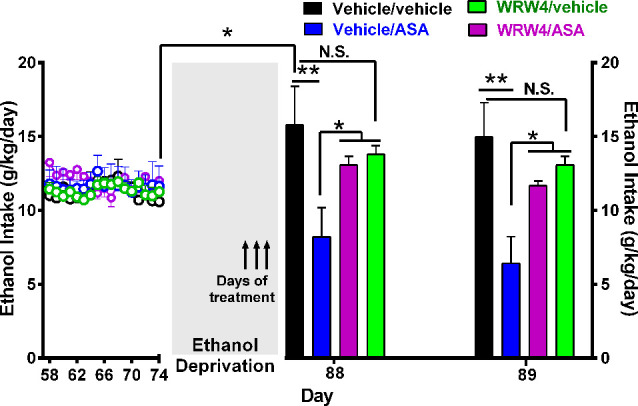
Oral administration of acetylsalicylic acid (ASA, 30 mg/kg per day) inhibited the alcohol postdeprivation relapse drinking, an effect blocked by the administration of WRW4, an antagonist of the lipoxin FPR2/ALX receptor. Following 74 days of ethanol intake, on the last 3 days of a 14-day ethanol deprivation, animals were treated as indicated by arrows. Bars show daily ethanol intake after the 2-week ethanol deprivation followed by 2 days of ethanol reaccess. The high ethanol intake of the control group (vehicle/vehicle group; black bar) on the first day (day 88) of alcohol reaccess (16.0 ± 2.0; mean ± SEM, n = 5) vs. its intake prior to deprivation (11.2 ± 0.34; mean ± SEM, n = 5) demonstrates the alcohol deprivation relapse [*P < 0.05 vehicle/vehicle group on the first day of ethanol re-exposure (black bar) compared to the mean of the last 11 baseline days of ethanol intake of the same group (empty black circles)]. Two-way analysis of variance of (treatment × day) performed on ethanol intake data obtained the first (day 88) and second (day 89) day of ethanol reaccess postdeprivation revealed significant effect of treatment (Ftreatment(3, 26) = 9.315), but not of day. Post hoc Fisher analysis indicated that ASA (vehicle/ASA group) administration 24 h before ethanol reaccess induced a significant (**P < 0.01) inhibition of ethanol intake vs. the vehicle/vehicle group the first and second day of ethanol reaccess, whereas pretreatment with WRW4, an antagonist of the lipoxin receptor (FPR2), blocked the ASA-induced reduction of alcohol relapse the first and second day of ethanol reaccess (*P < 0.05 vehicle/ASA group vs. WRW4/ASA and WRW4/vehicle group). Data are presented as mean ± SEM, n = 6 rats per experimental group. N.S., not statistically significant.